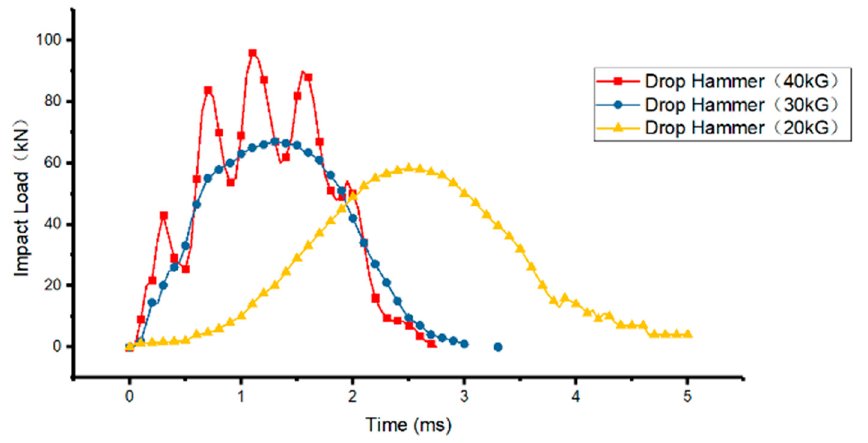
Figure 12. The impact-force–time curves.